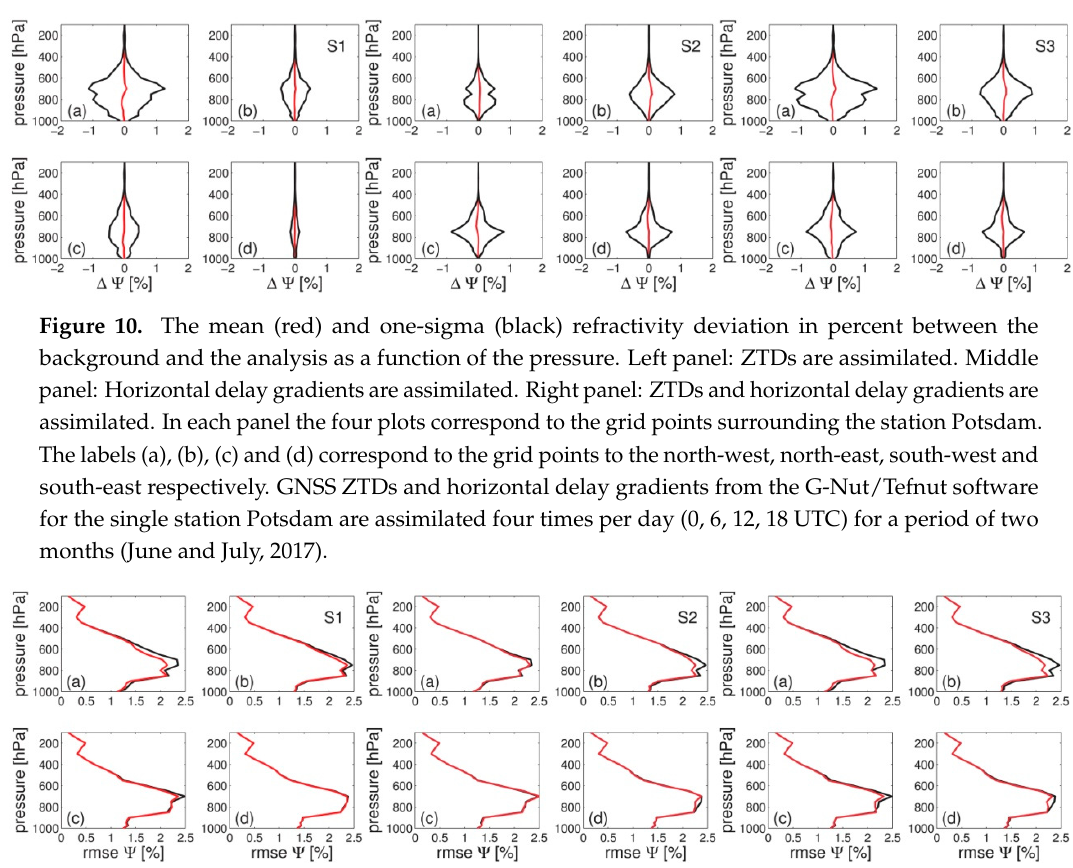
panel: Horizontal delay gradients are assimilated. Right panel: ZTDs and horizontal delay gradients are assimilated. GNSS ZTDs and horizontal delay gradients from the G-Nut/Tefnut software for the single station Potsdam are assimilated four times per day (0, 6, 12, 18 UTC) for a period of two months (June and July, 2017).